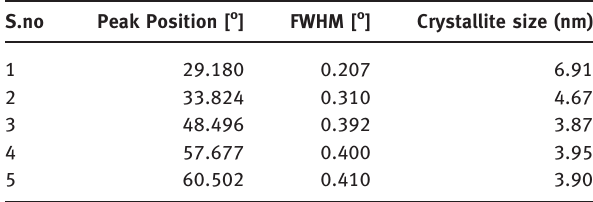
Table 4: Crystallite size for Ce 2 Zr 2 O 8 calculated (using Debye- Scherer equation).